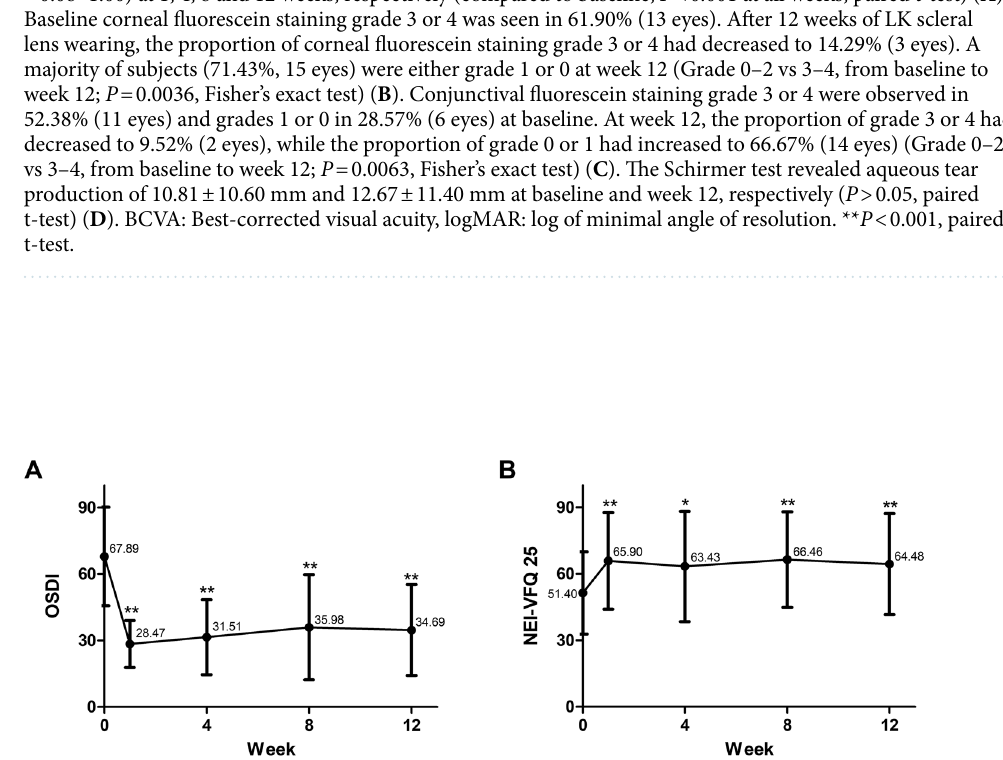
Figure 2. Subjective efficacy outcomes of the LK scleral lens clinical trial. At baseline, OSDI was 67.89 ± 22.29 (range 20.45–100.00), which significantly decreased to 28.47 ± 10.60 (range 6.25–47.73), 31.51 ± 16.88 (range 2.08–60.00), 35.98 ± 23.73 (range 2.50–72.73), and 34.69 ± 20.51 (range 6.82–72.92) at weeks 1, 4, 8, and 12, respectively (compared to baseline; P < 0.001 at all weeks) ( A ). NEI-VFQ-25 score was 51.40 ± 18.50 (range 22.00–81.04) at baseline, which significantly improved to 65.90 ± 21.82 (range 22.63–97.05), 63.43 ± 24.89 (range 17.27–97.73), 66.46 ± 21.59 (range 26.50–98.75), and 64.48 ± 22.76 (range 16.59–95.94) at weeks 1, 4, 8, and 12, respectively (compared to baseline; P < 0.001 at weeks 1, 8, and 12, P < 0.01 at week 4) ( B ). OSDI: Ocular surface disease index, NEI-VFQ-25: National Eye Institute 25-Item Visual Function Questionnaire. * P < 0.01, paired t-test, ** P < 0.001, paired